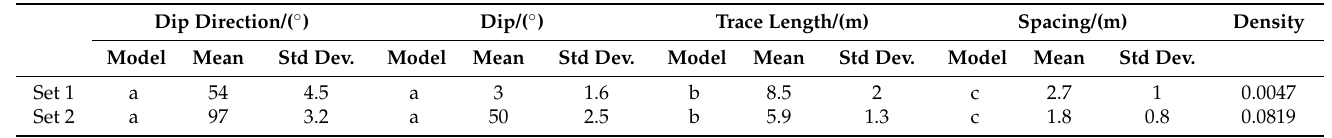
Figure 2. The rock slope with two sets of fractures. Table 1. Statistics of geometric characteristics for two sets of fractures.